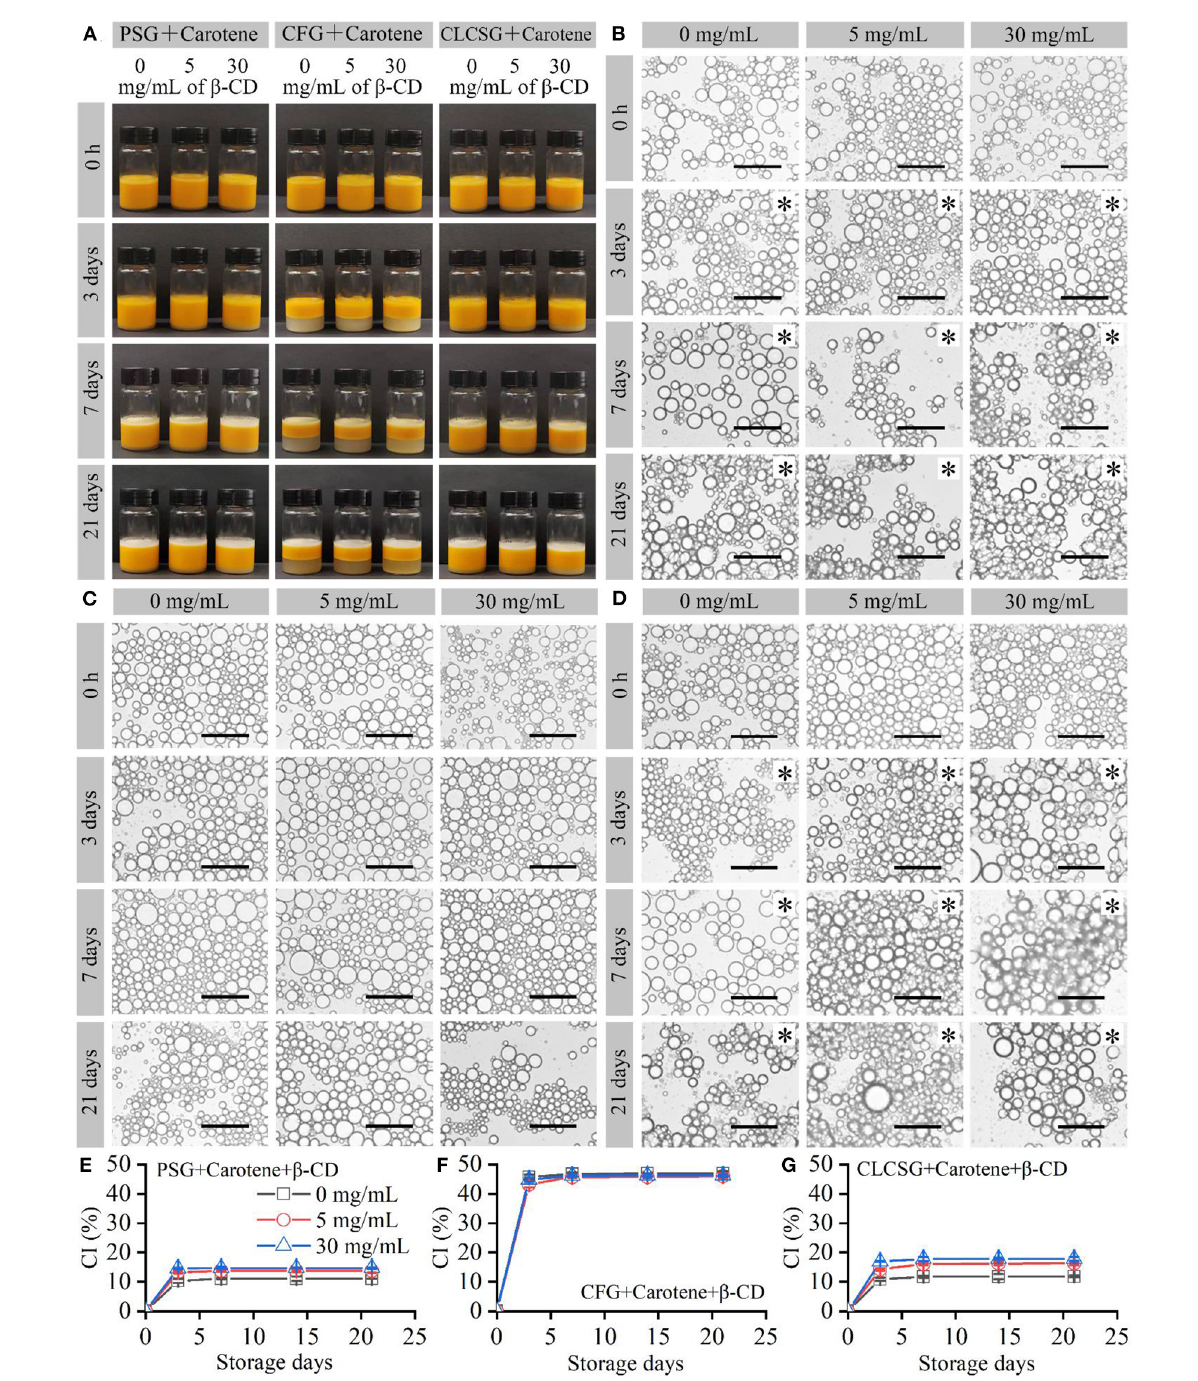
FIGURE3 Preparation and storage (4 ◦ C) of β -carotene/fish oil-loaded emulsions stabilized by gelatins with β -CD. (A) Digital camera images of the emulsions. (B–D) Optical microscopy images of the emulsion droplets stabilized by PSG, CFG, and CLCSG, respectively, with and β -CD. Black asterisks indicate emulsion gels. Scale bars indicate 50 µ m. (E–G) CI values of the